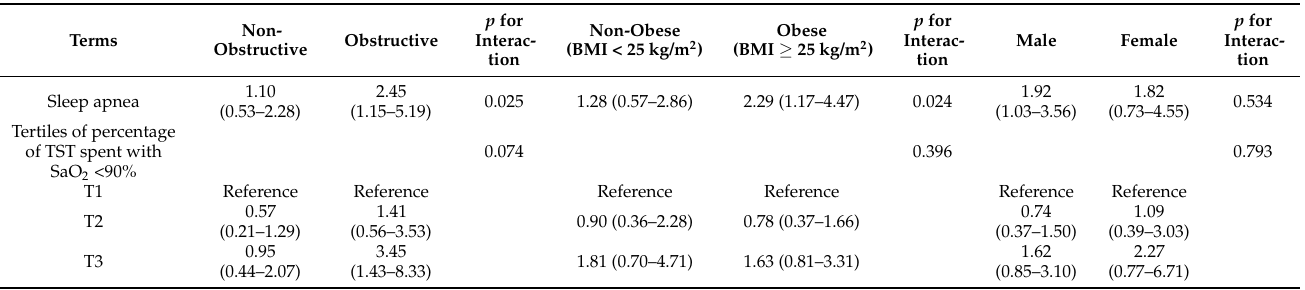
Table 5. Association of sleep apnea and nocturnal hypoxemia with AF in different subgroups of HCM